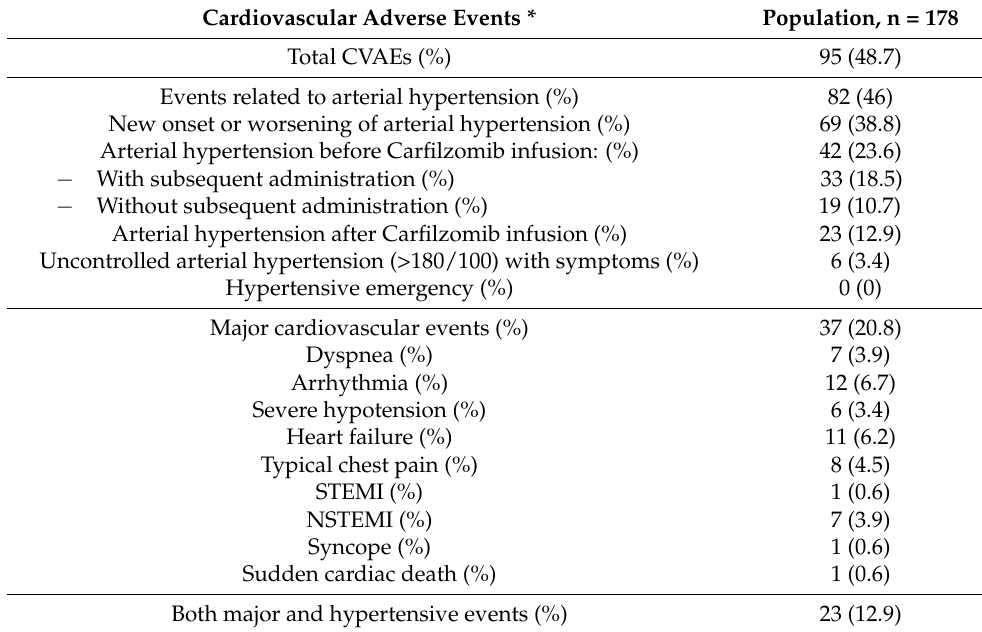
Table 3. Incidence of cardiovascular adverse events (CVAEs) during Carfilzomib